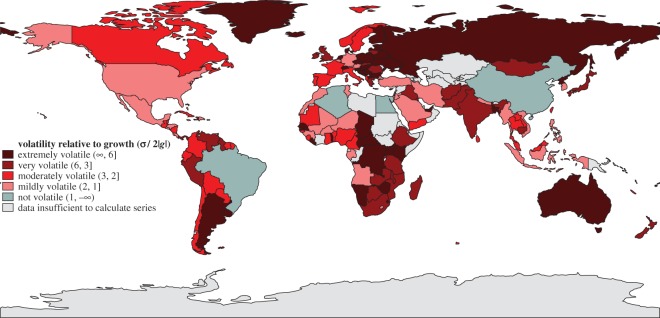
Volatility of per capita daily kilocalorie availability, based on annual data 1961–2011. Trend inversions g↦−g are unlikely if the mean fluctuation σ is less than twice the size of the long-term growth trend (σ<2|g|). All four countries labelled in green—Egypt, China, Algeria and Brazil—also have improving long-term trends, and so are considered resistant.